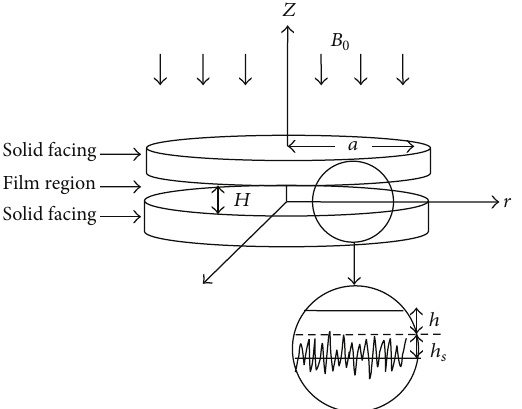
Figure 1: The physical configuration of rough circular plates in the presence of transverse magnetic